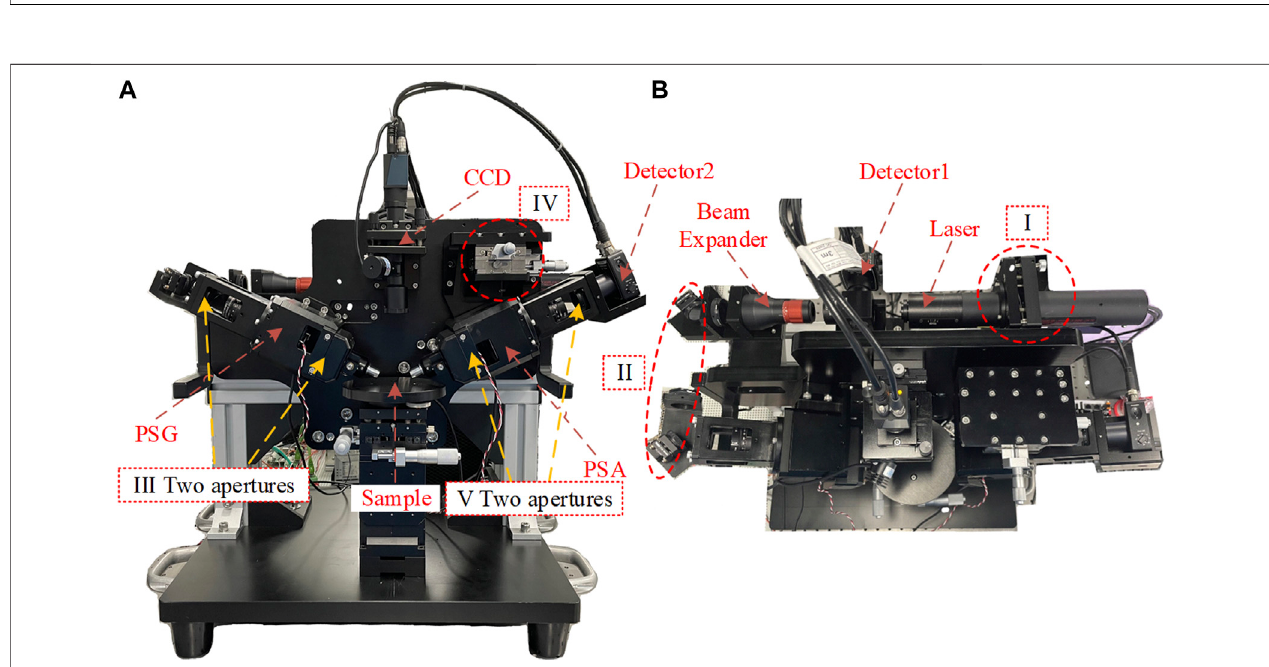
FIGURE 2 | Instrumentation of SWE (A) front view and (B) top